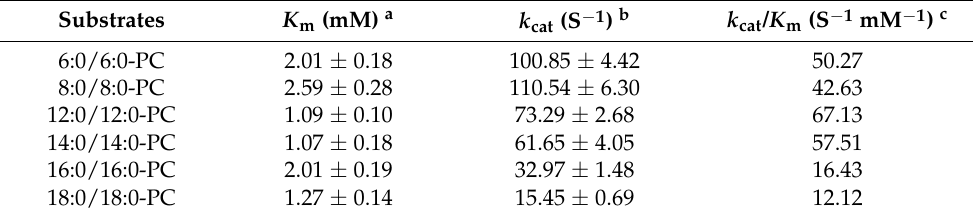
Figure 2. Effects of pH and temperature on the hydrolytic activity of SkPLD. ( A ) The enzymatic activity of SkPLD was measured under various pH buffers. The enzymatic activity value obtained at pH 8.0 was taken as 100%. ( B ) pH stability of SkPLD. The residual activity of SkPLD was determined after treating for 2 h under various pH buffers. The residual activity value obtained at pH 8.0 was taken as 100%. ( C ) The enzymatic activity of SkPLD was measured at various temperatures. The enzymatic activity value obtained at 60 °C was taken as 100%. ( D ) Thermostability of SkPLD. The residual activity was determined after treating for 4 h at different temperatures. Values were means ± standard deviation from three independent experiments. Table 1. Kinetic parameters for the hydrolysis of SkPLD towards different substrates.